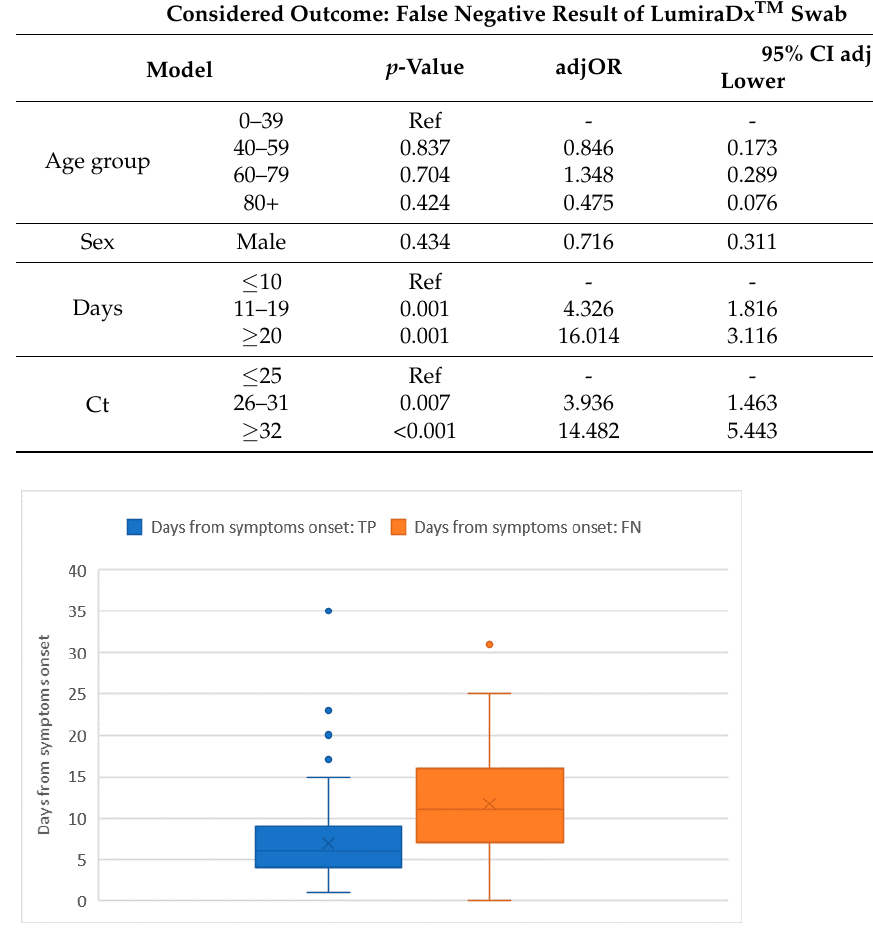
Figure 2. Days from symptoms’ onset distribution among true positive (TP) and false negative (FN) tests.